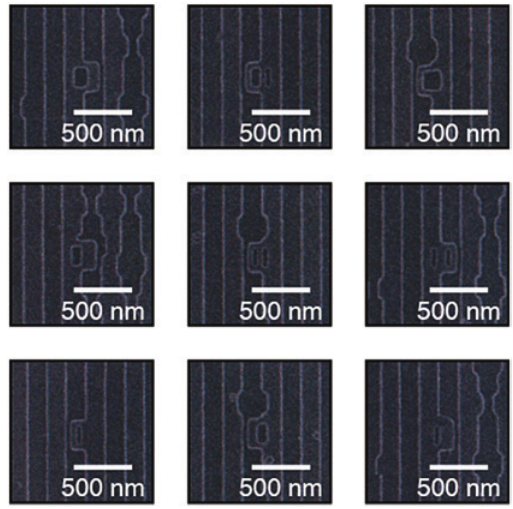
Figure 4: SEM images of embedded nanometric structures inside the periodic structures. Source: Adapted with permission from The Optical Society: Optics Express